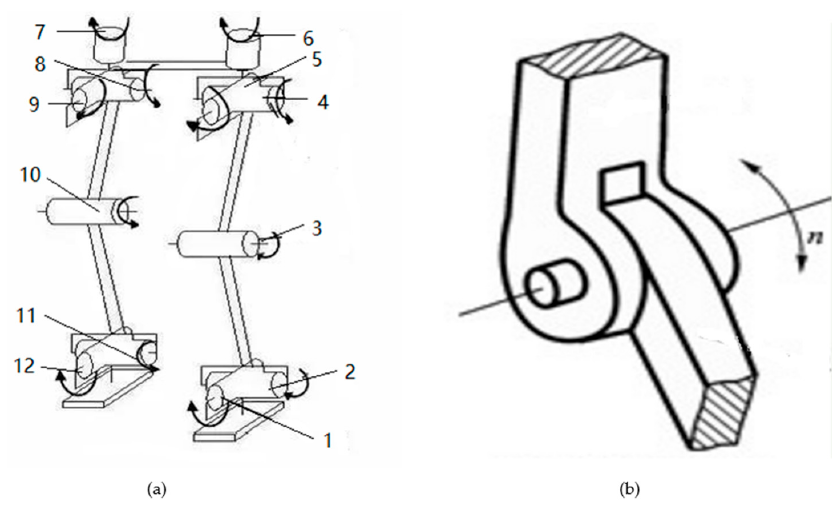
Figure 3. The mechanical structure of the bipedal locomotion. ( a ) The classic mechanical structure with 12 degrees of freedom; ( b ) The rotating hinge structure.